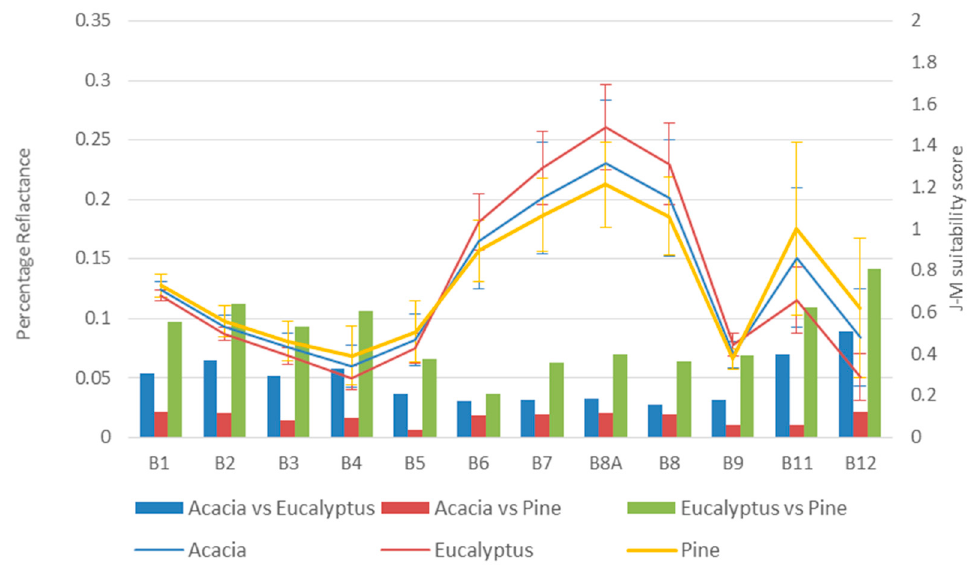
Figure 6. Average spectral signatures of the training samples, the standard deviation of the spectral signatures (shown as error bars), and the J–M separability scores for all of the training samples for Study Area 1 (WC).